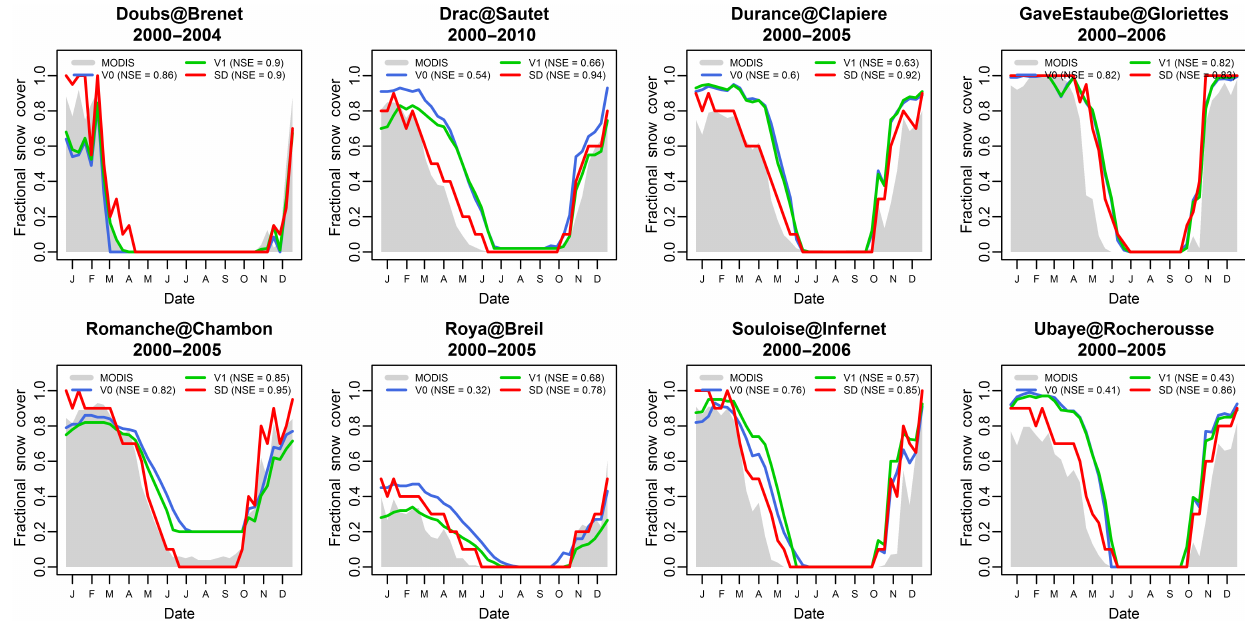
Figure 5. Fractional snow cover regime on eight mountainous catchments. Comparison of MOD10 FSC product with the three model versions. For each catchment, the considered period is given. NSE values are calculated on FSC regimes.